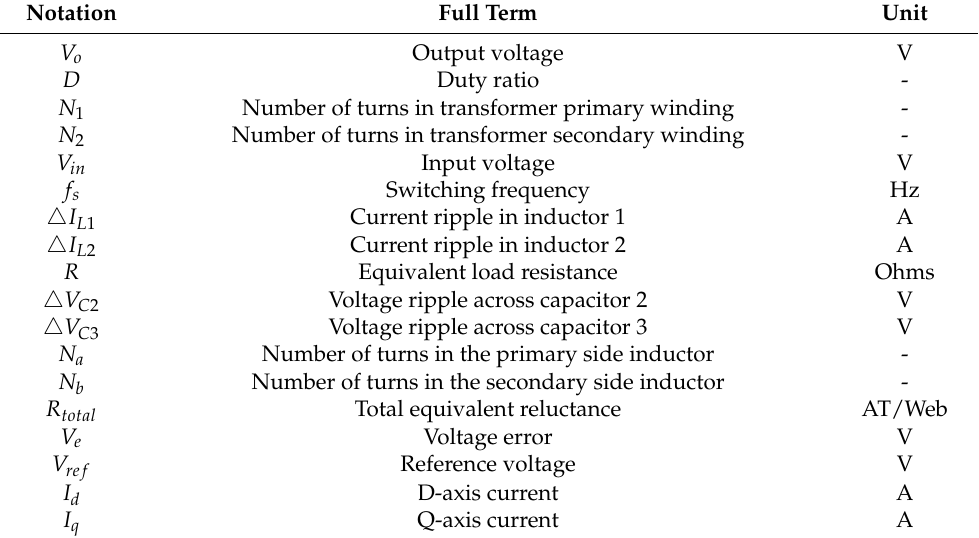
Table A2. List of notations and their